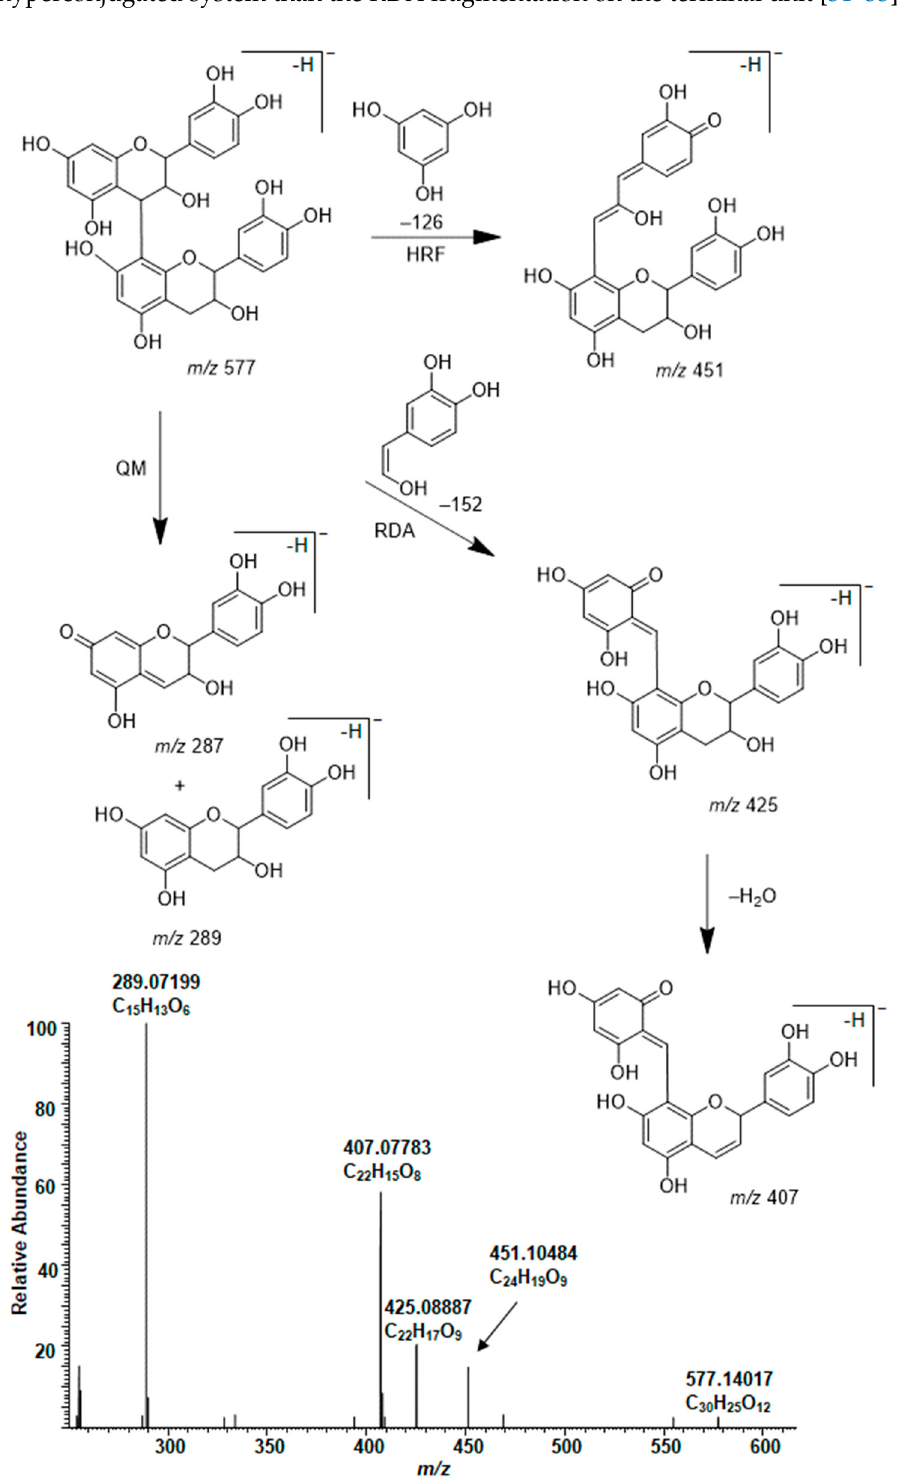
Figure 3. Characteristic fragmentation pathway and the MS/MS of B-type procyanidin dimer in the leaf extract of Cunninghamia lanceolata . The mechanisms are heterocyclic ring fission (HRF), retro-Diels ‒ Alder (RDA) fragmentation and quinone methide (QM) cleavage [31–33].